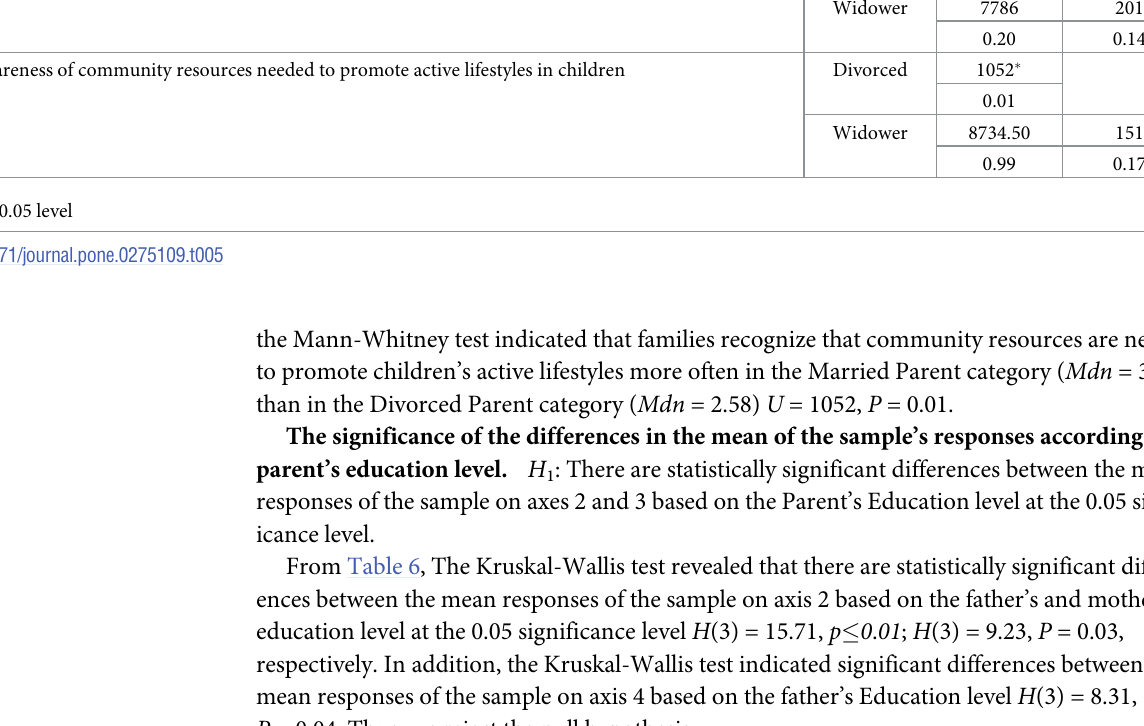
Table 6. Kruskal–Wallis test, the significance of the differences in the mean of sample‘s responses according to Parent‘s education level. Questionnaire axes